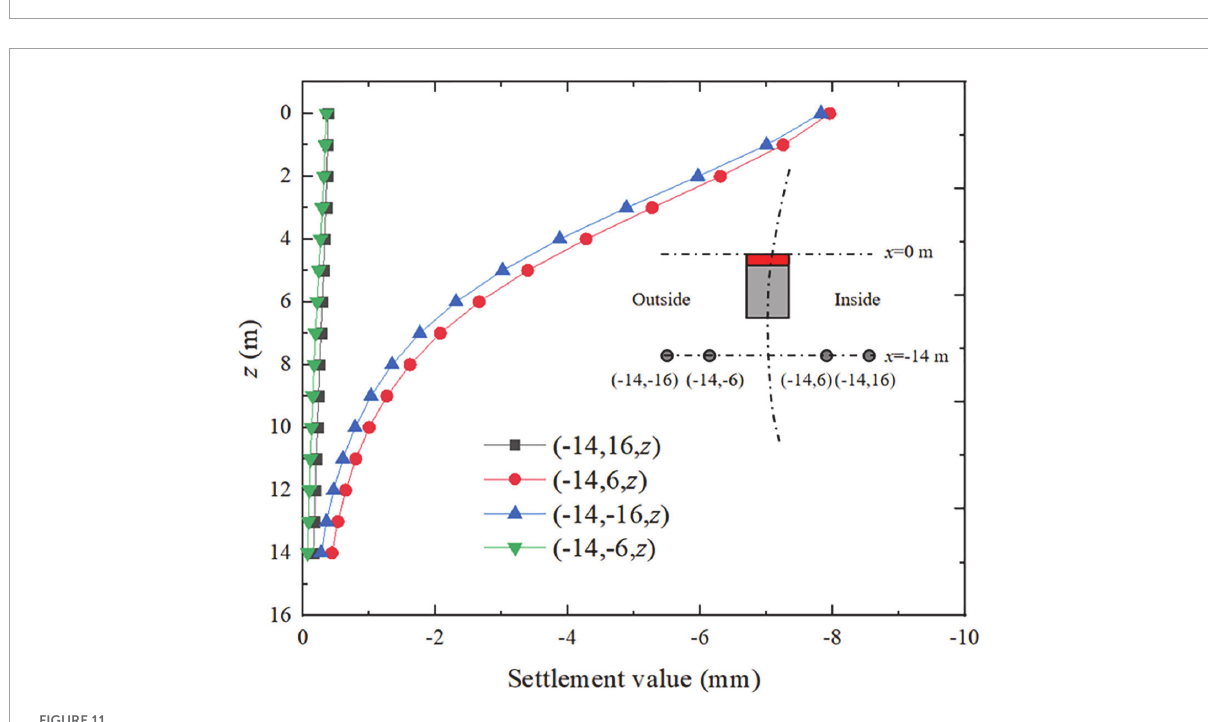
FIGURE11 Comparison of settlement curves of pile foundations on both sides of inner and outer